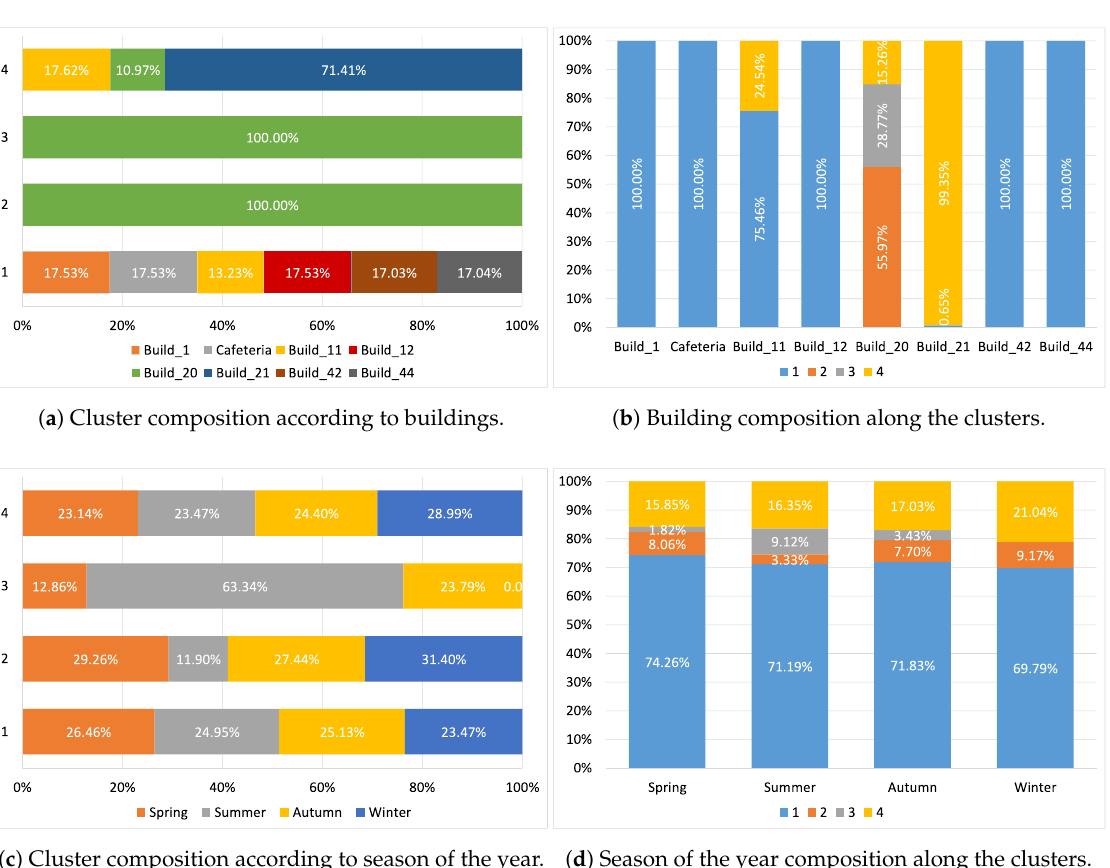
different features. Figure 5b,d and f (right side) represent the presence of the different features in the clusters, where the different features are the columns and the clusters are represented by colours.